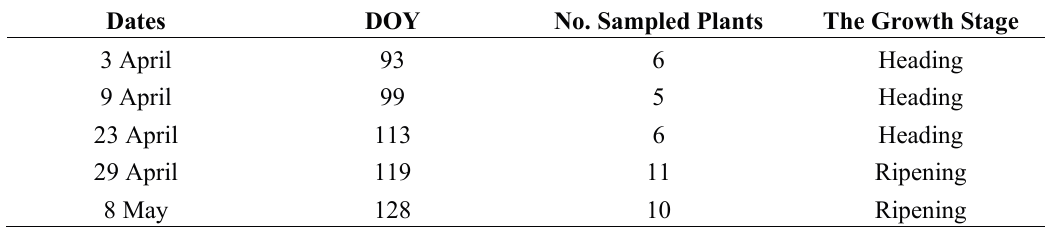
Table 1. The day of year (DOY) on which field campaigns were conducted in 2014, the number of plants sampled in each field campaign, and the growth